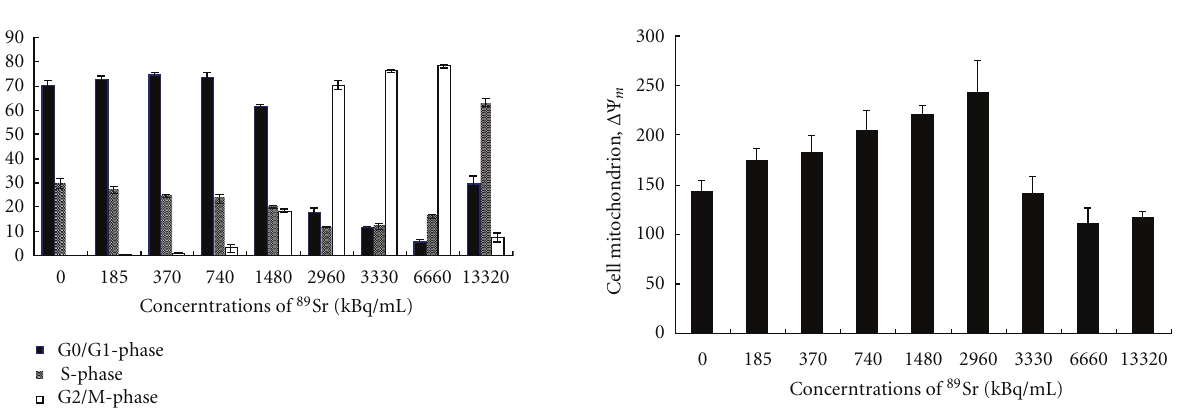
Figure 3: MCF-7 cell cycle retardation due to being induced by 89 Sr of various radioactive concentrations.